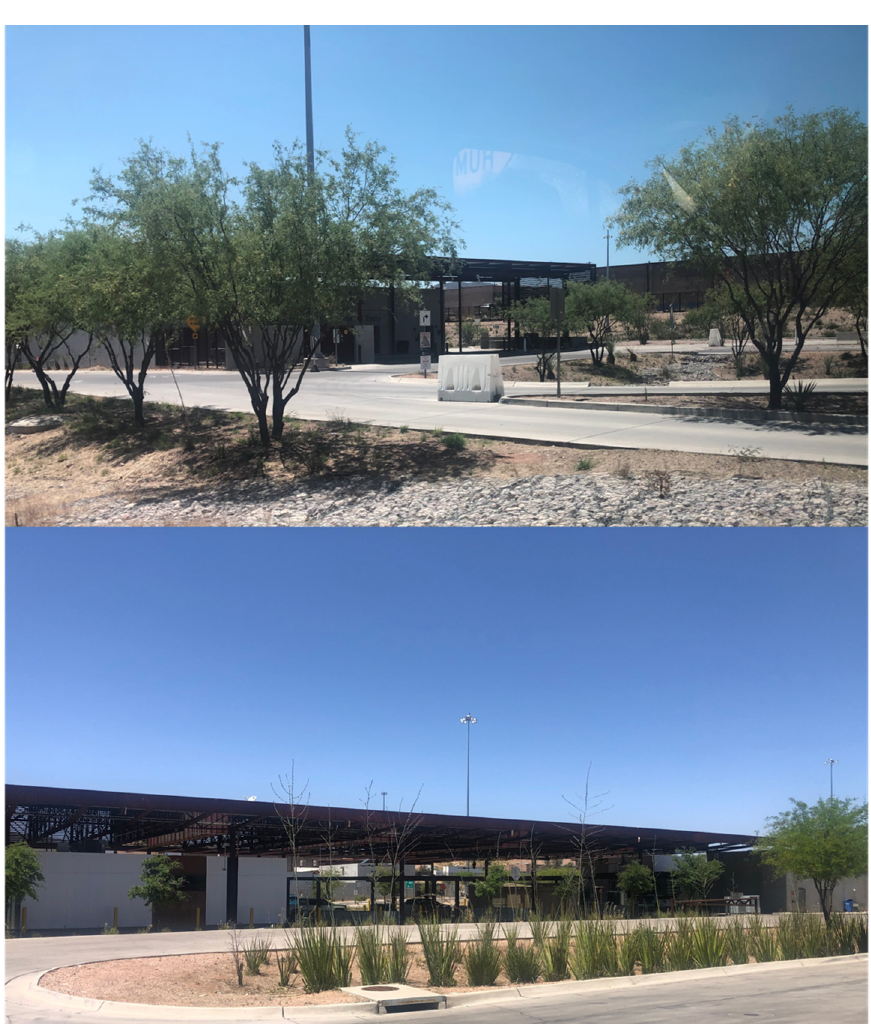
Figure 5. GI projects at the Mariposa Port of Entry (credit: Zuniga-Teran).